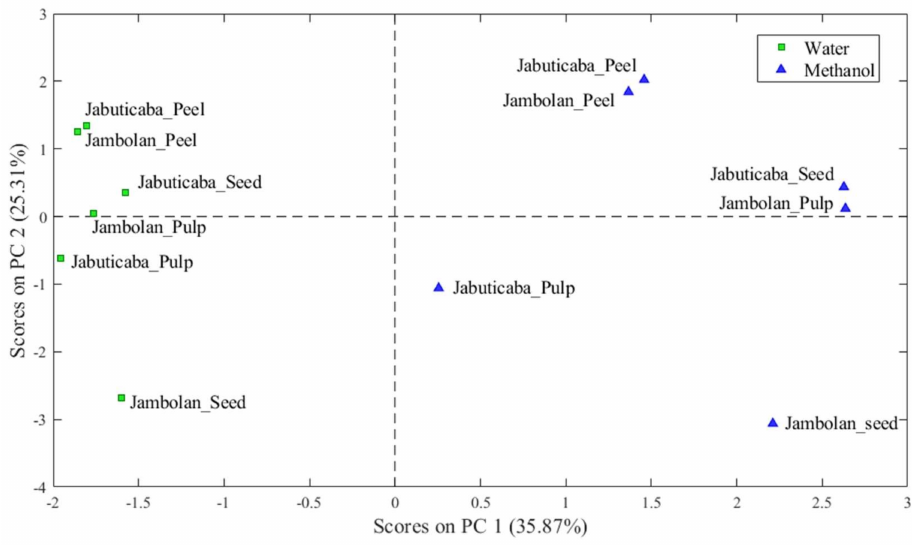
Figure 1. PC1 and PC2 jabuticaba and jambolan samples.